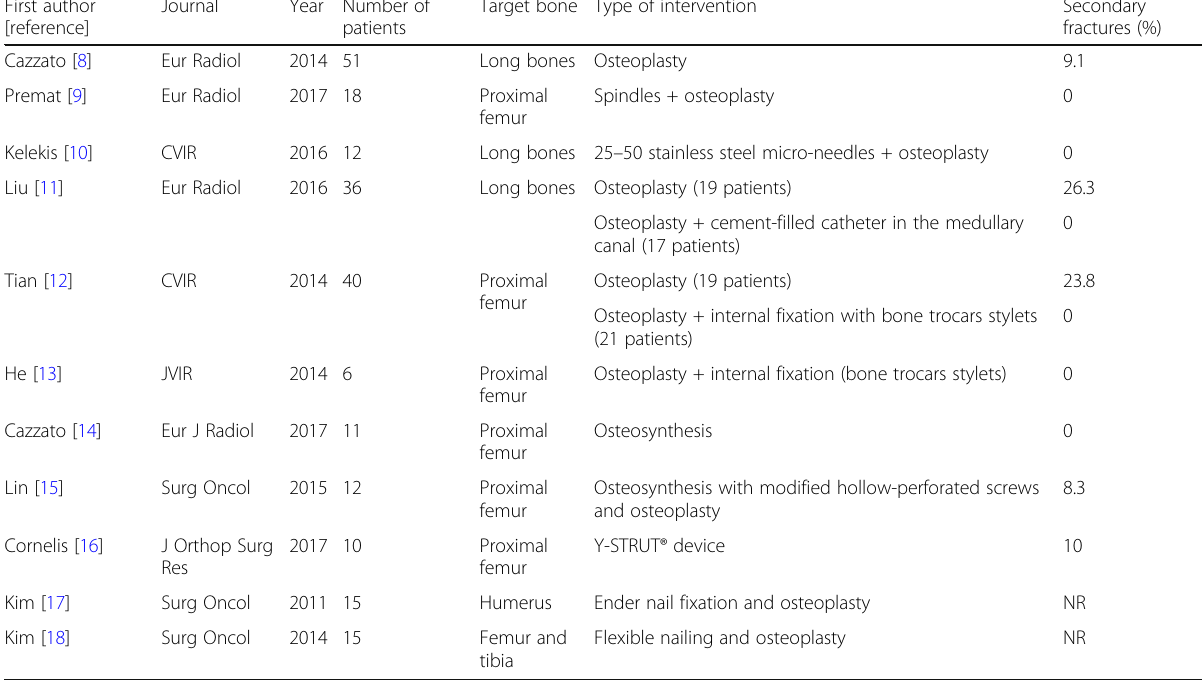
Table 1 Published studies reporting on different consolidative techniques in long